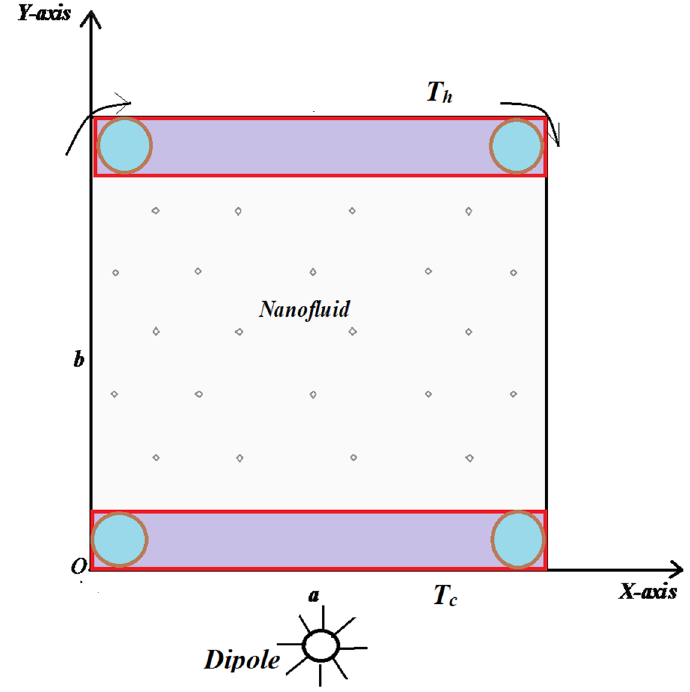
Figure 1. Problem schematic diagram.